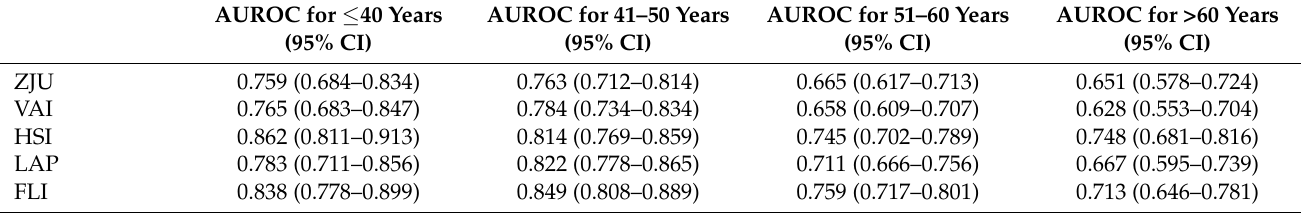
Table 5. Diagnostic accuracy of the indices for different age